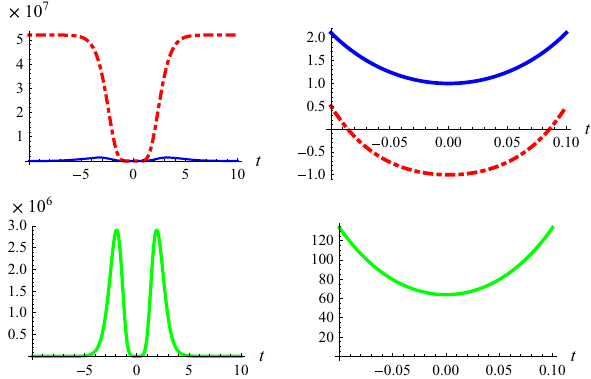
Fig. 2 Time evolutions of ϕ χ (blue, line), (cid:19) (red, dash dotted) and δ v (green, dotted). The upper panels show the behavior of ϕ χ and (cid:19) at a large scale (left) and in a region close to the bouncing (right). The lower panelsshow thebehaviorof δ v atalargescale(left)andinaregionclose to the bouncing (right). We choose c = 0 . 5, s = 1, t 0 = 0, n = 10, and K = 1. The initial conditions are set to ϕ χ ( 0 ) = 1 and ˙ ϕ χ ( 0 ) = 0